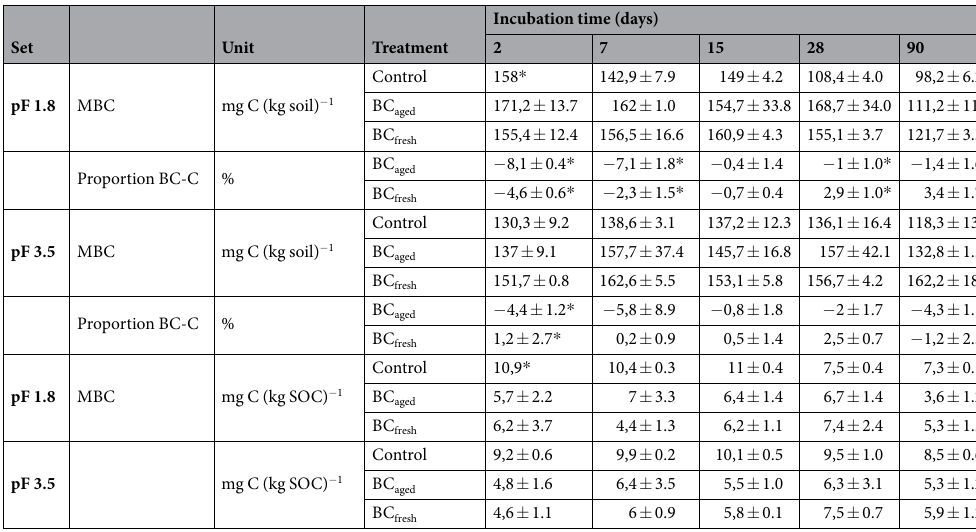
Table 3. Microbial biomass C (MBC) of all treatments during the 90 days of incubation. Asterisks indicate significant differences (p < 0.05). * No